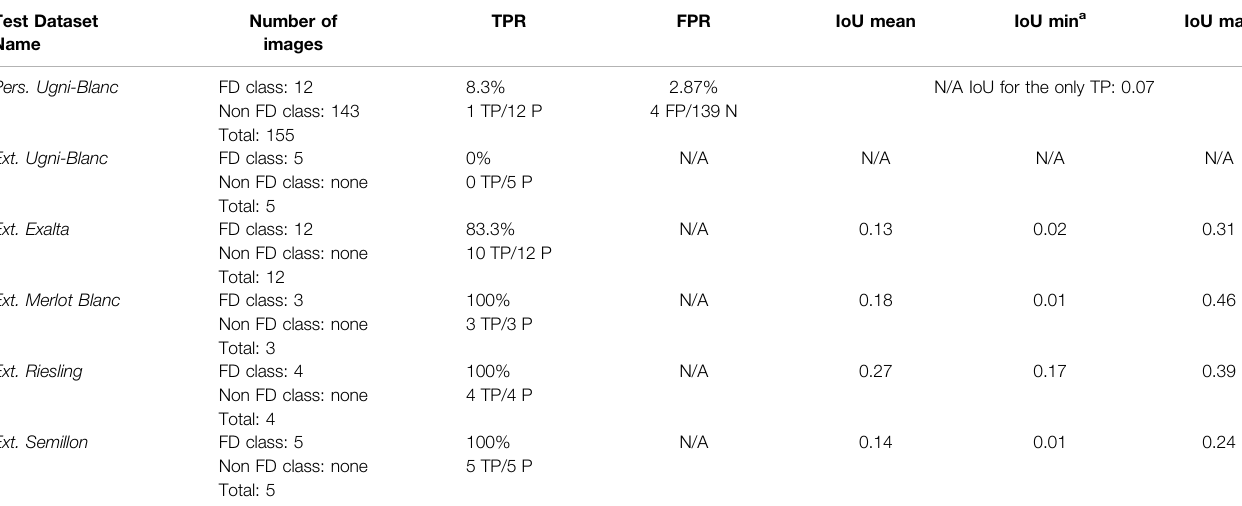
TABLE4| Summaryofinferenceresultsonothergrapevinevarieties ’ datasets,presentingtheTruePositiveRate(TPR),FalsePositiveRate(FPR),mean,minandmaxvalues of Intersection over Union (IoU).